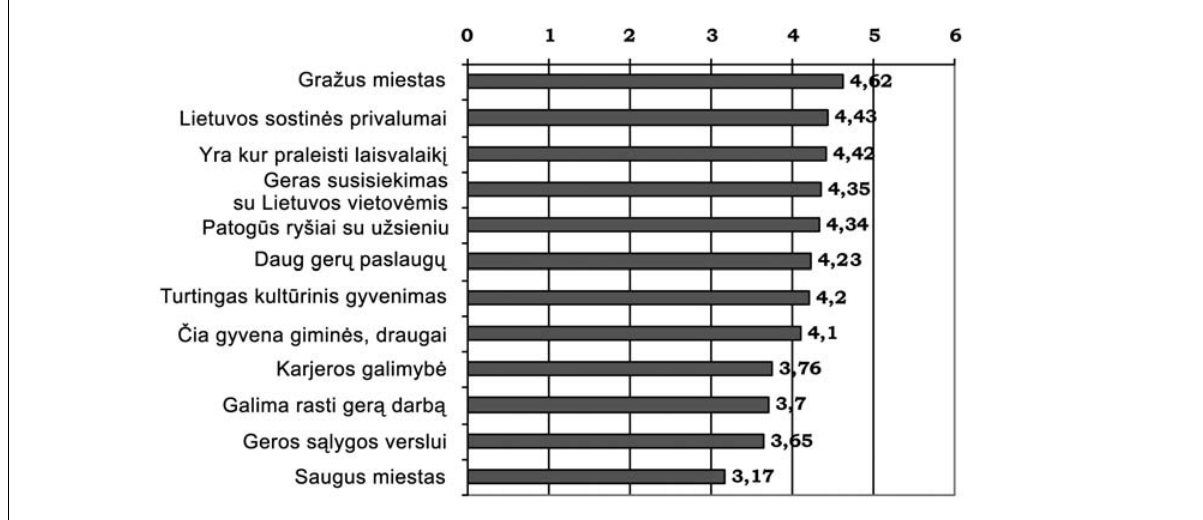
Fig 10. Assessment of attractiveness in Vilnius according to the citizens’ poll results,